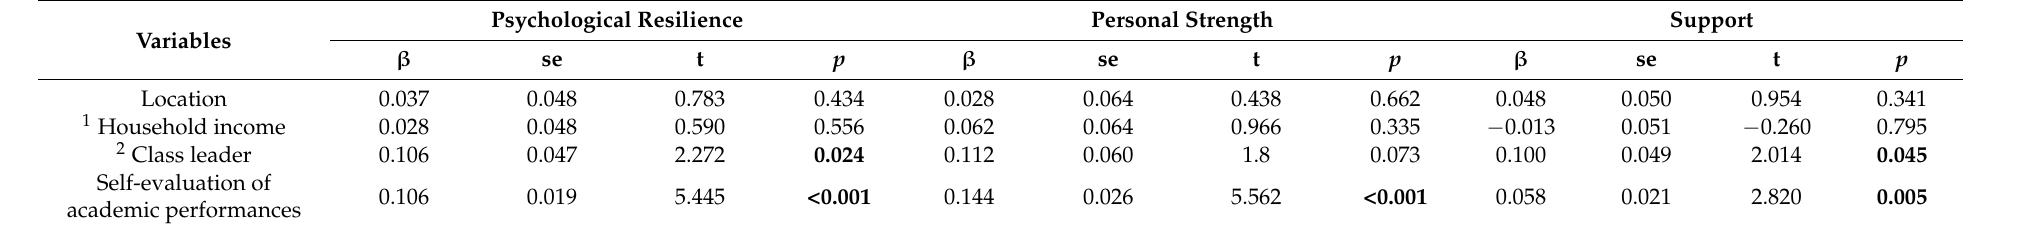
Table 7. Multivariable linear regression analysis of factors associated with psychological resilience among non-left-behind children.